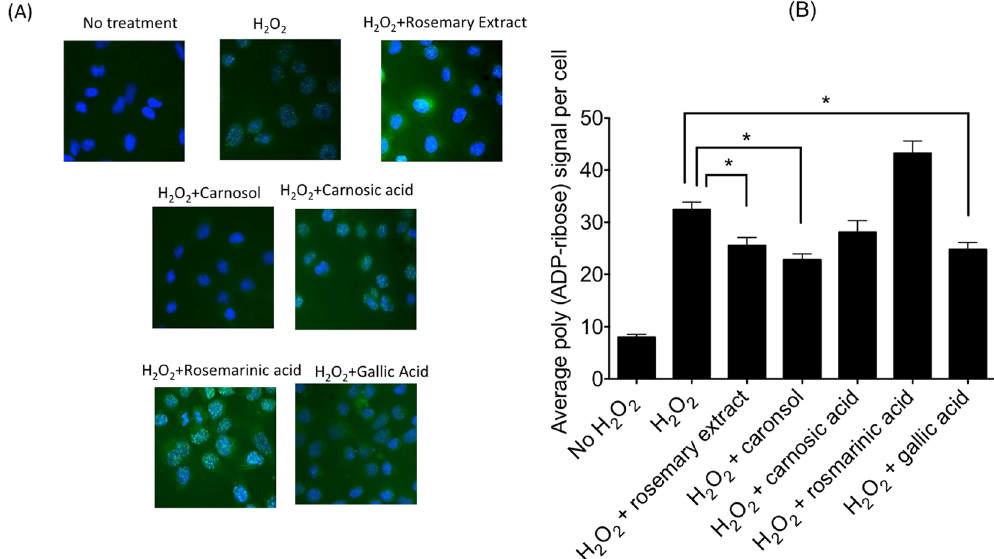
Figure 4. In vivo PARP inhibitory effect by rosemary extract and its major compounds. ( A ) Representative images of H 2 O 2 induced poly (ADP-ribose) formation as green signals. Blue signals are nuclei. ( B ) Quantitative analysis of poly (ADP-ribose) formation by green pixel analysis. Average green pixels per cell (arbitrary unit).